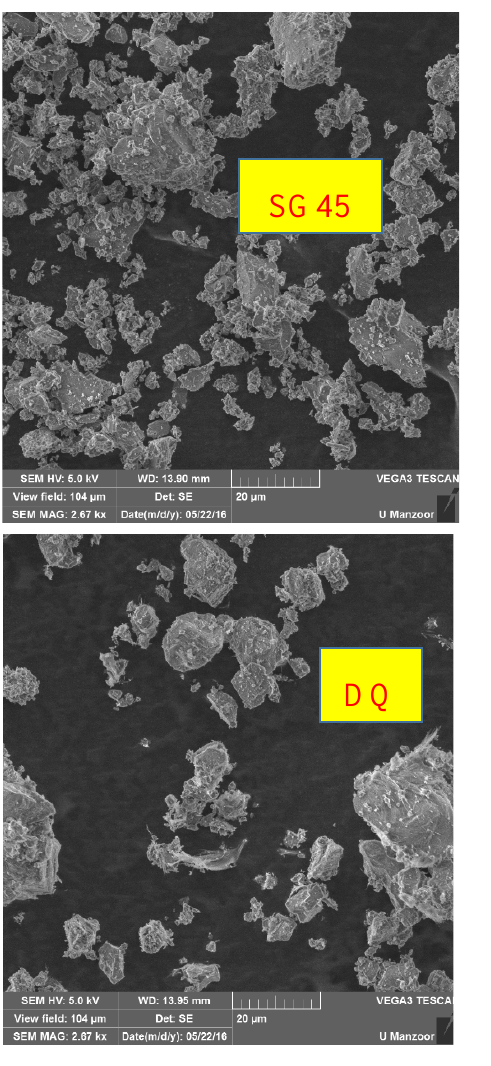
Figure 4. SEM images of materials: cement (C); fly ash (FA) having regular spherical particles; quarry dust irregular particles (QD); and granite sludge irregularly-shaped porous particles (GS45 and GS25).